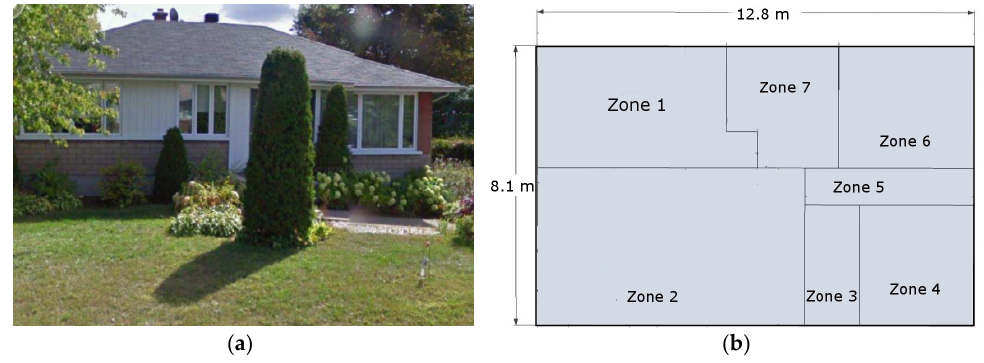
Figure 3 . Experimental building [21]: ( a ) picture of the building; and ( b ) zones of the building.